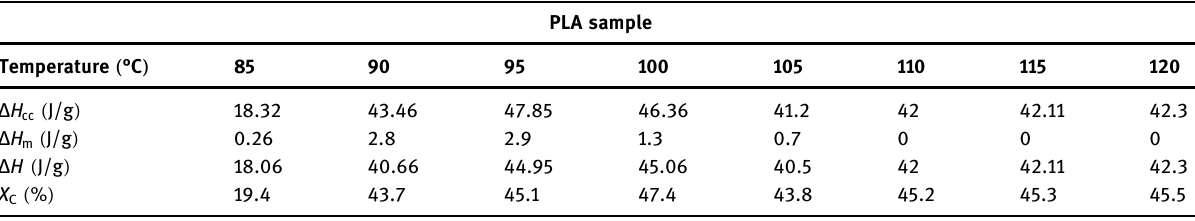
Table 4: Crystallinity calculated by Isothermal DSC results ( 2nd heating